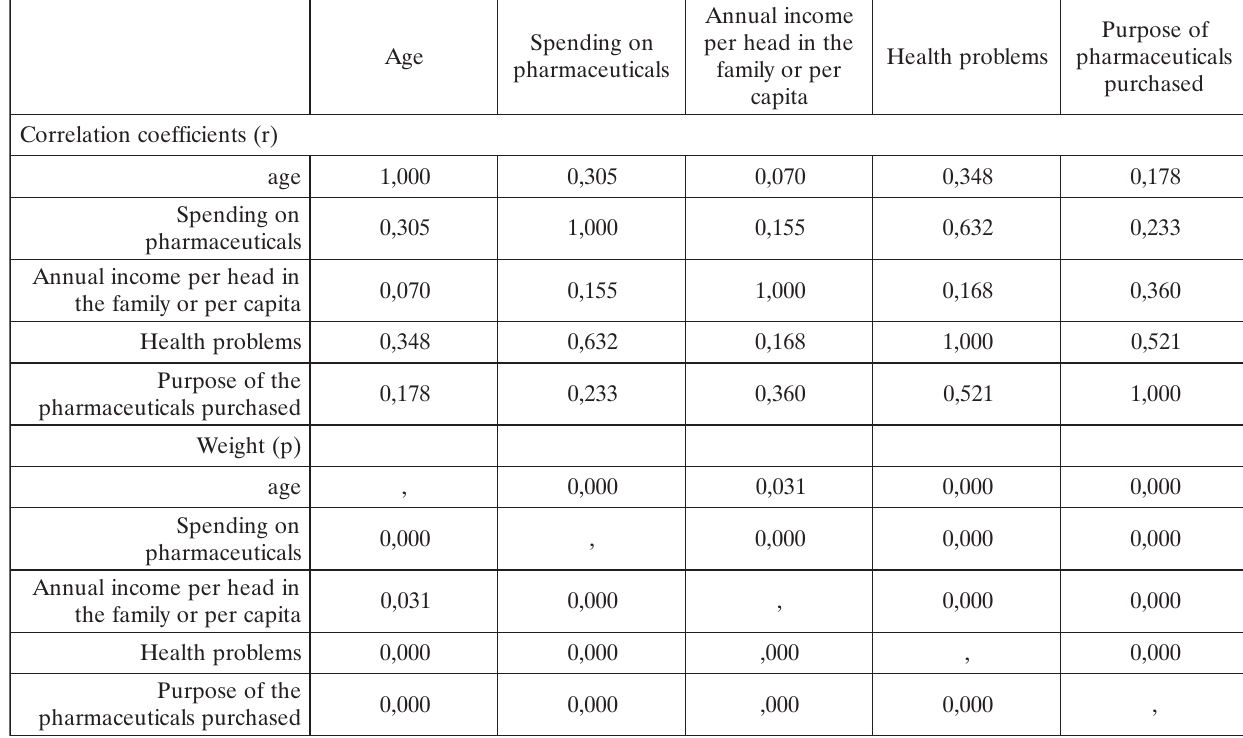
Table 2. Inter-correlation of characteristics of pharmaceutical